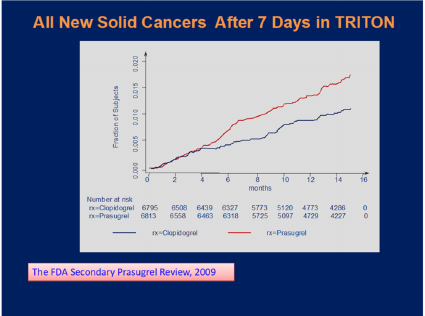
Figure 1. Incidence of new solid cancers in TRITON